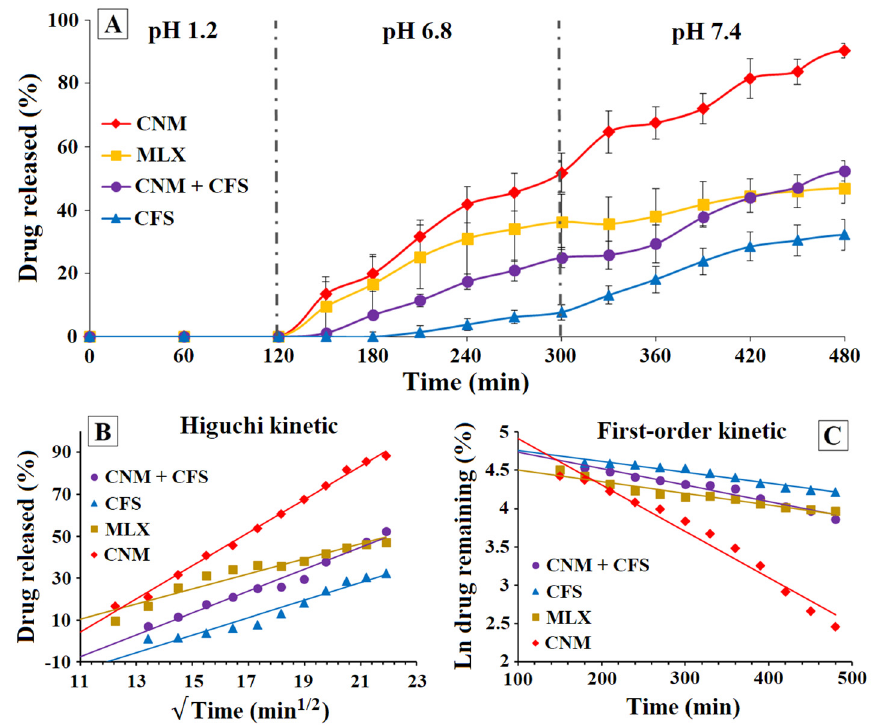
Figure 6. ( A ) Dissolution rate of MLX with buffer changes (pH 1.2, 6.8 and 7.4) for MLX raw material and 0.85–1.00 mm size diameter granules of CNM, CFS and CNM + CFS. ( B ) Higuchi kinetic model applied for MLX release from MLX raw material, multiparticulate colonic systems CNM + CFS, CFS and CNM. ( C ) First-order kinetic model applied for MLX release from MLX raw material, multiparticulate colonic systems CNM + CFS, CFS and CNM.